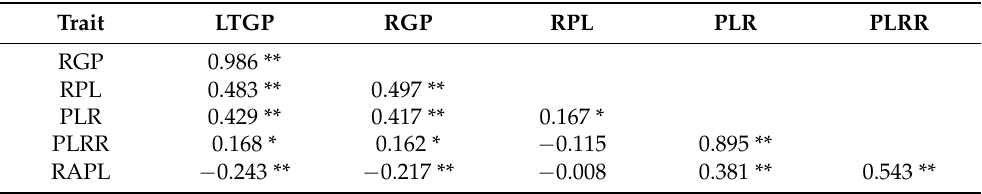
Table 1. Pearson’s correlation coefficients between the six different indices evaluated in this study.